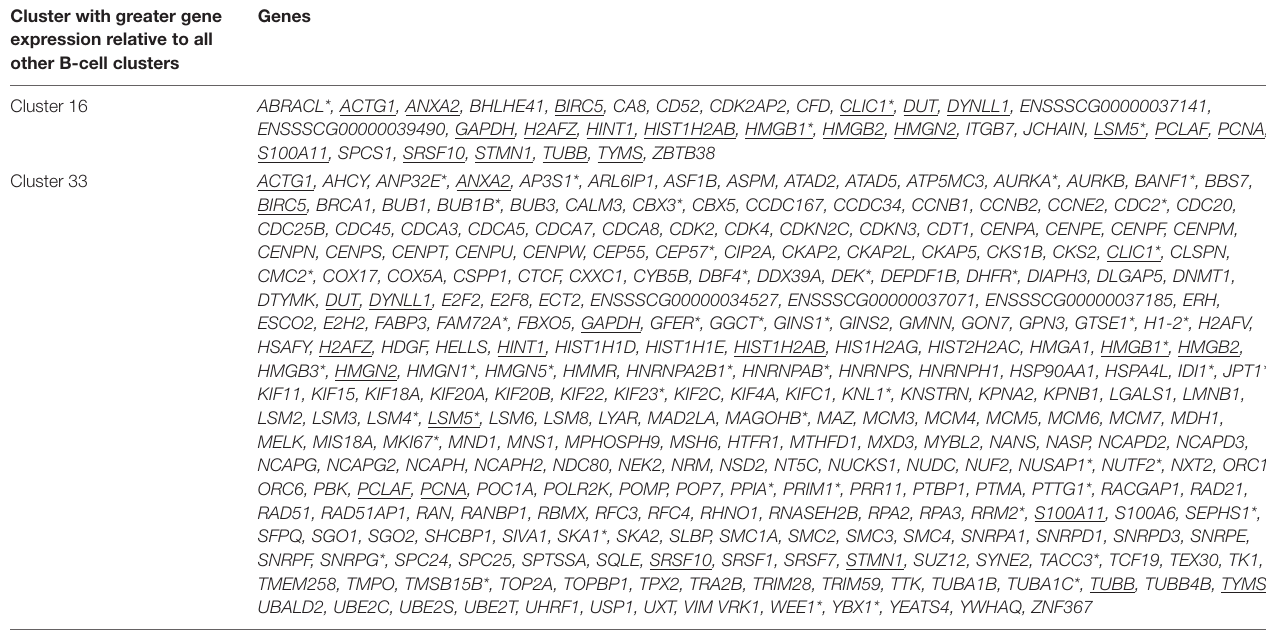
*Refer to gene name replacement in Materials and Methods section.